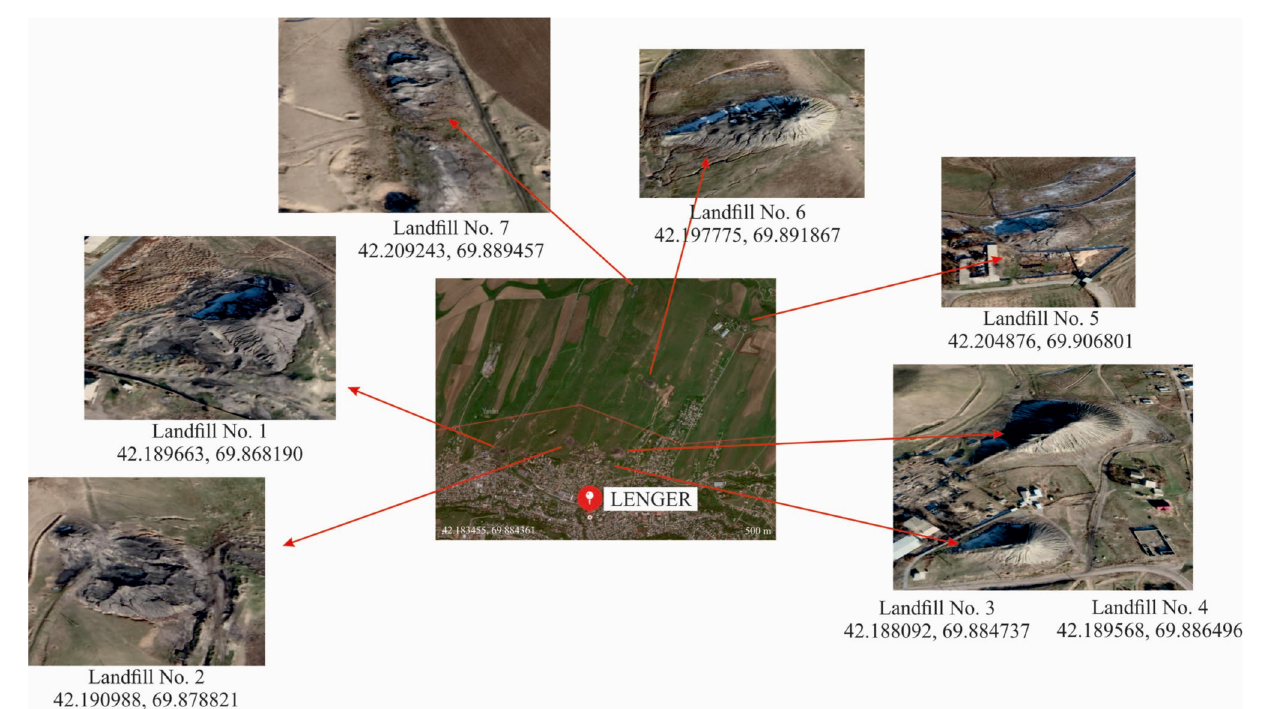
Figure 1. Map of the location of coal mining waste landfills on the territory of Lenger (based on Yandex Maps).